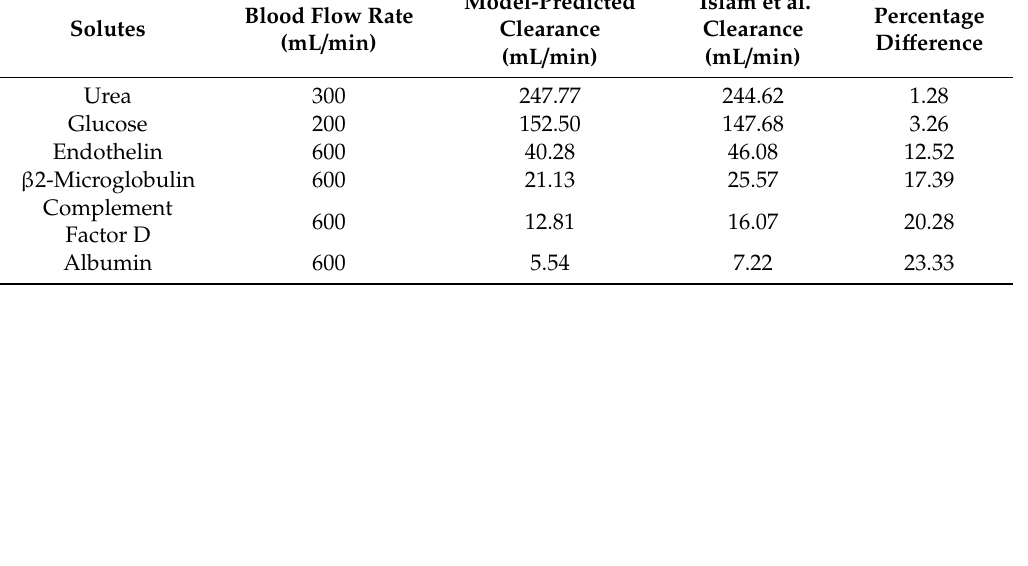
Table 4. Maximum percentage difference of this model with literature data at varying blood flow rate [21].